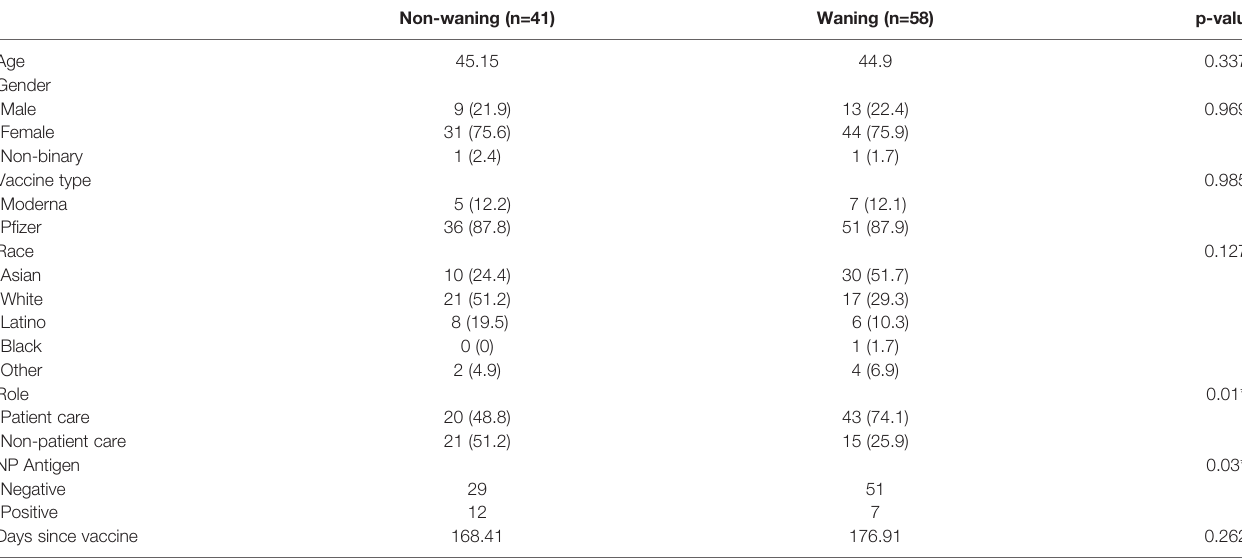
TABLE 3 | Demographic variables in patients with and without waning antibody